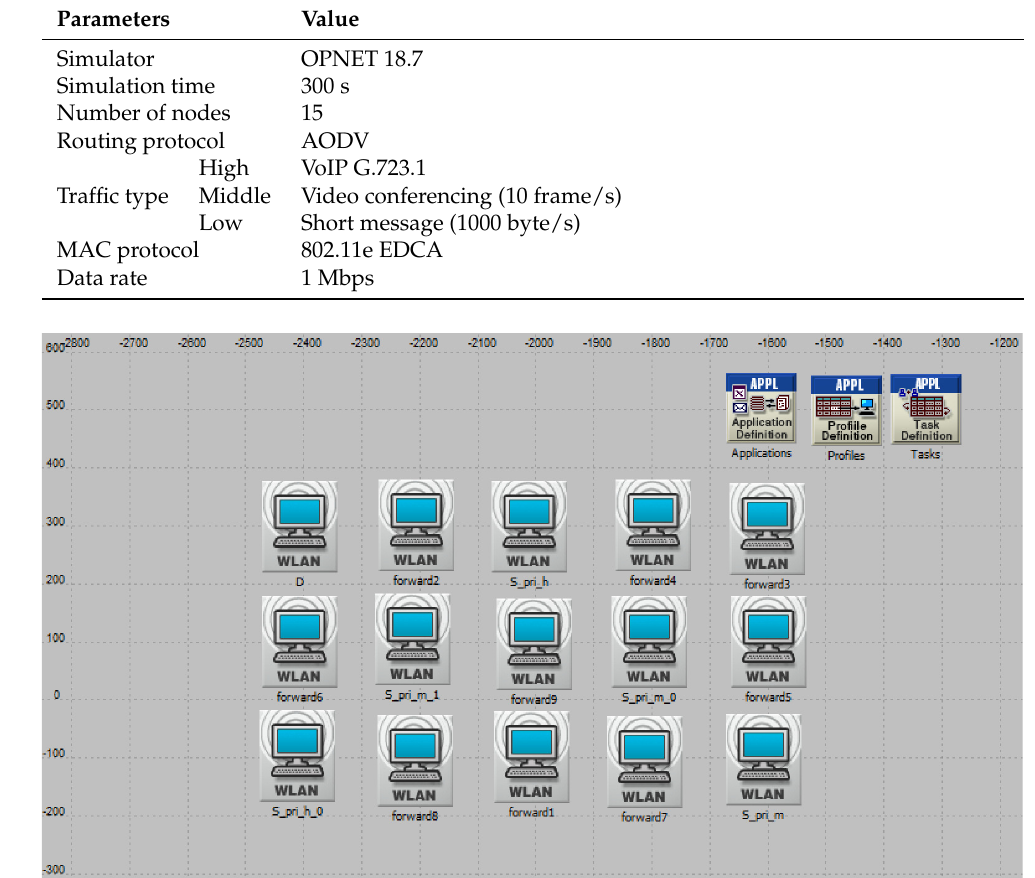
Table 2. Simulation parameters setup.